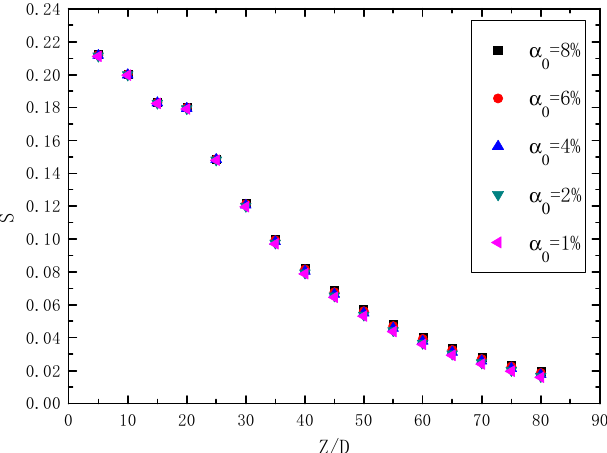
Figure 9. The swirl number at each position at different concentrations ( Y =6.2, Re = 20,000).